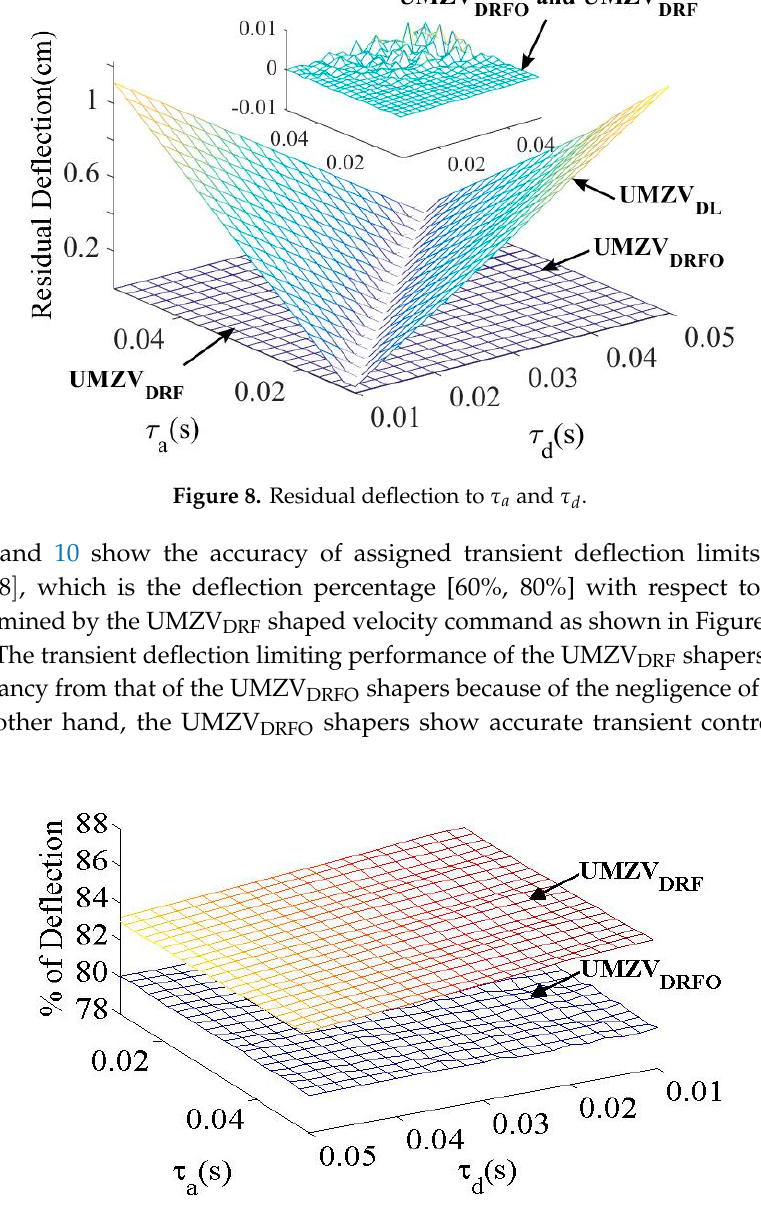
Figure 9. Transient deflection of UMZV DRF and UMZV DRFO shapers at (cid:1830) (cid:3033)(cid:3039)(cid:3036)(cid:3040) = 0.8 .